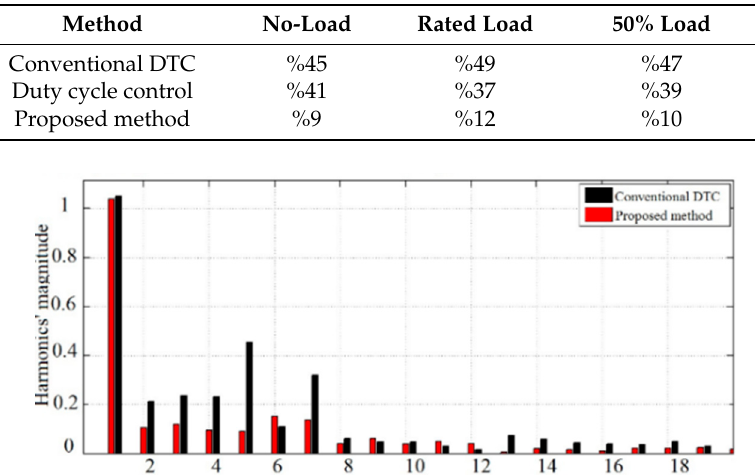
Figure 12. Current THD of the conventional DTC and proposed method.